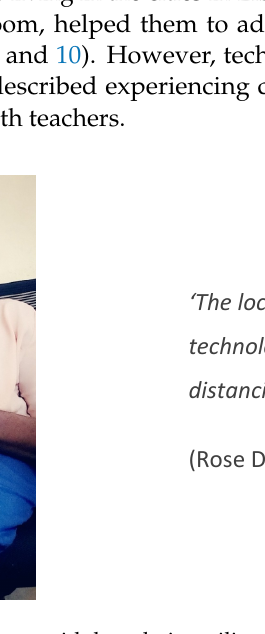
Figure 9. Alt-text: A woman with long hair smiling holding a smartphone.